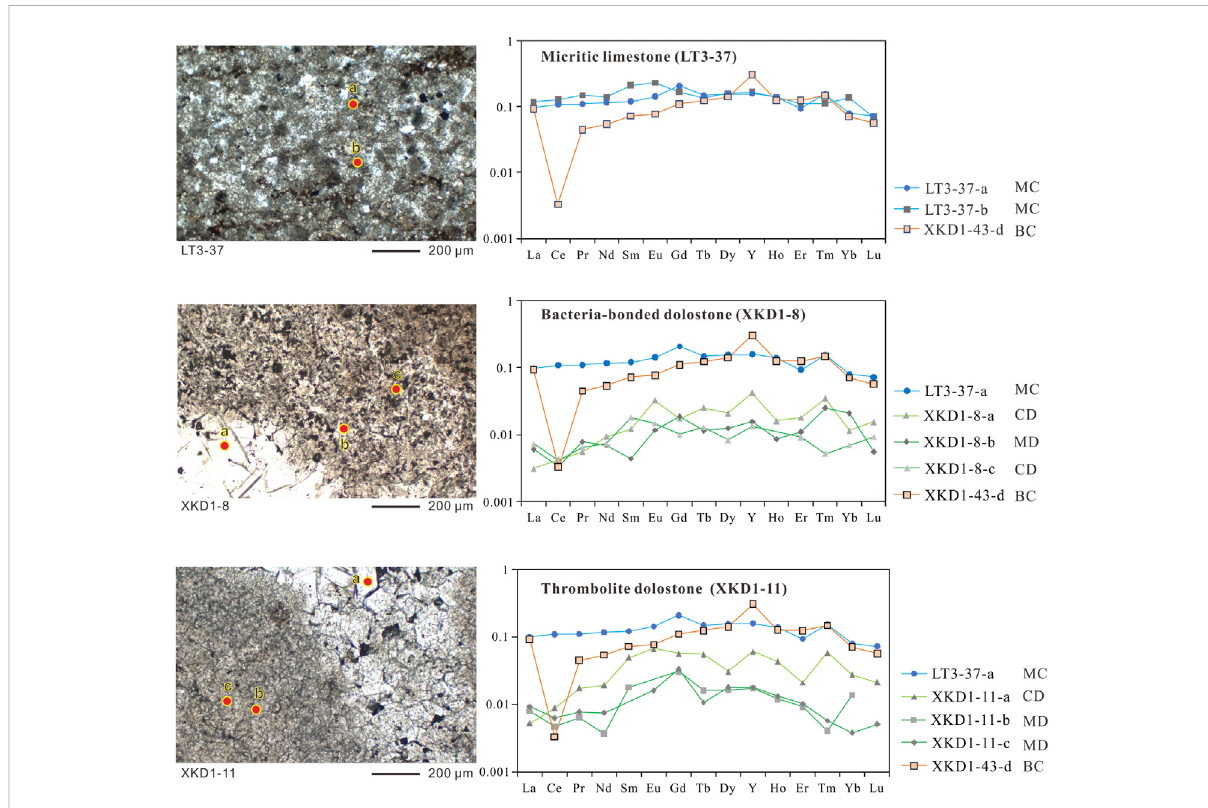
FIGURE 7 The REE+Y patterns of different types of dolomites (sampes LT3-37, XKD1-8, and XKD1-11) in the Xiaoerbulake Formation of the well